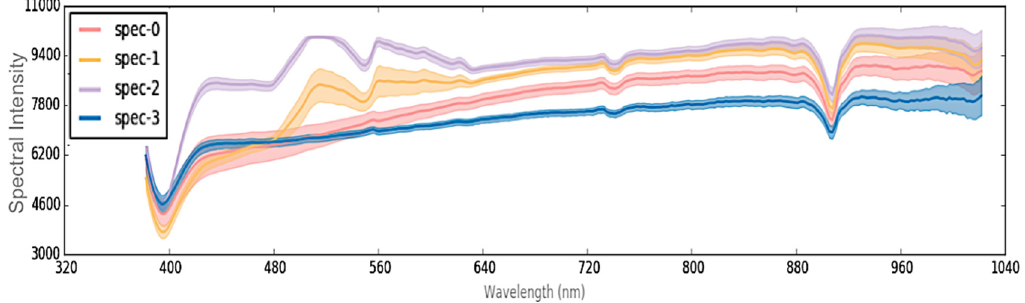
Figure 9. Wavelength plot for corresponding colormap image depicting varying levels of spectral radiance intensity for different areas of the RTV-2 .